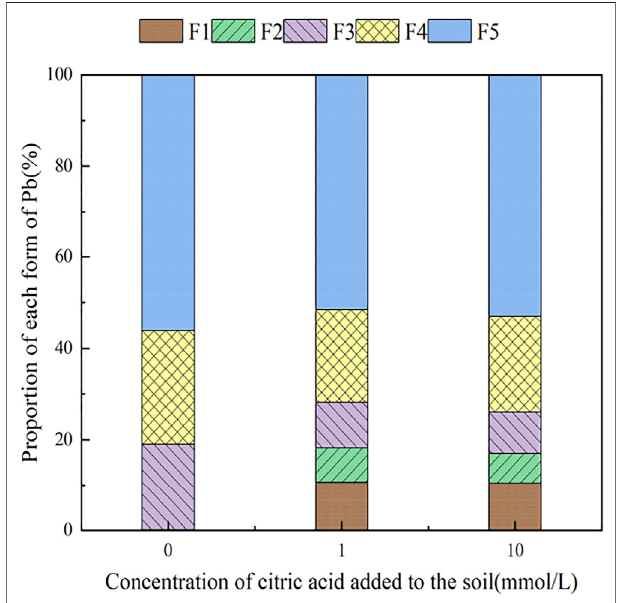
FIGURE 2 | Distribution of Pb in the original soil after adding citric acid.